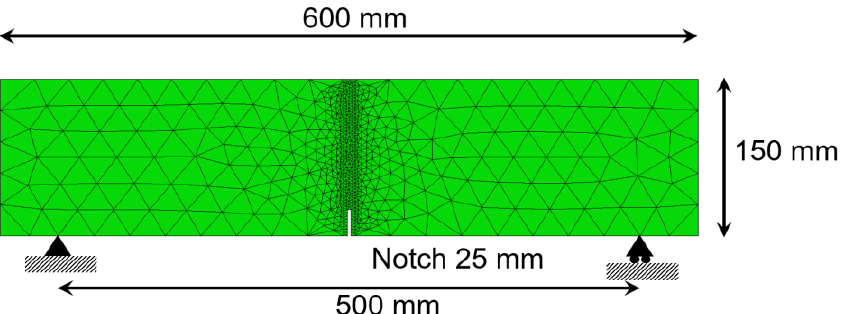
Figure 3. Mesh used in the numerical